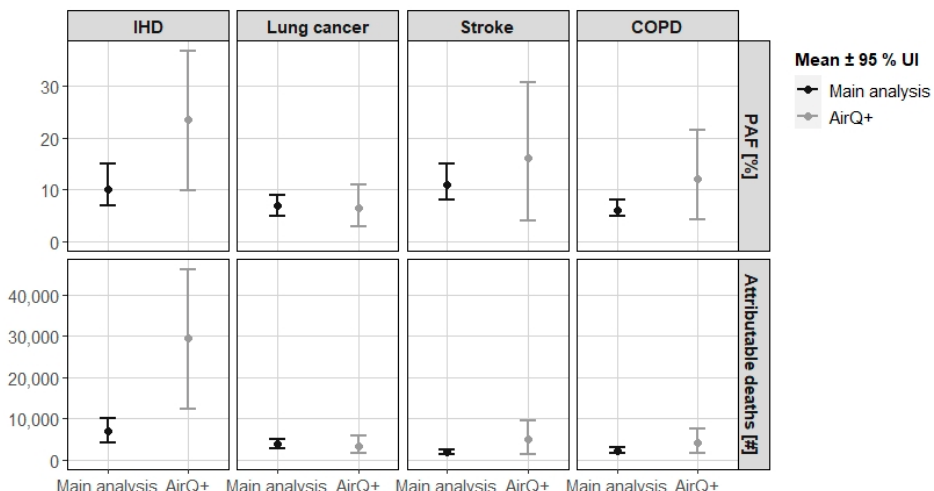
Figure 5. Comparison of the main analysis with estimates generated with AirQ+. COPD = chronic obstructive lung disease. IHD = ischemic heart disease. PAF = population attributable fraction. UI = uncertainty interval.